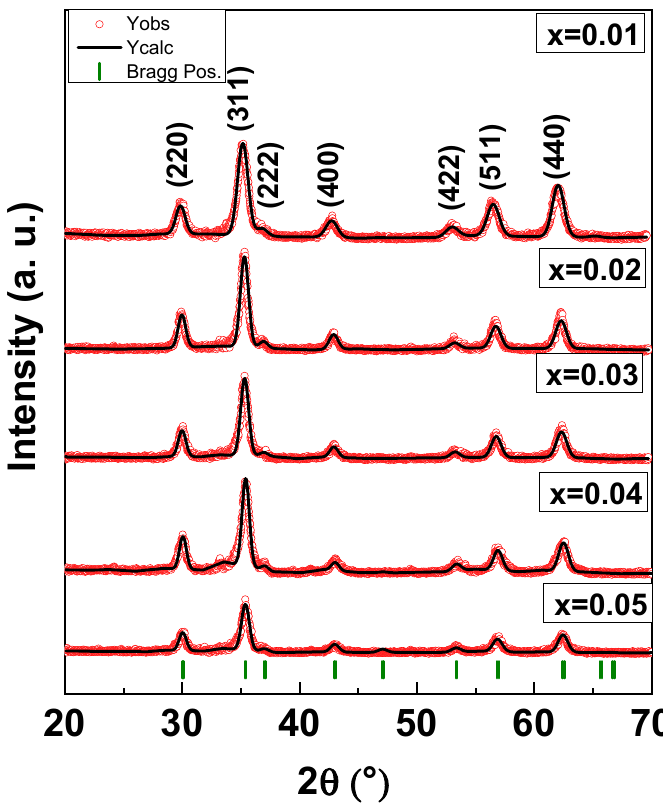
Figure 1. XRD powder patterns of Mn 0.5 Zn 0.5 Eu x Sm x Fe 1.5 − 2x O 4 (0.01 ≤ x ≤ 0.05) NPs.